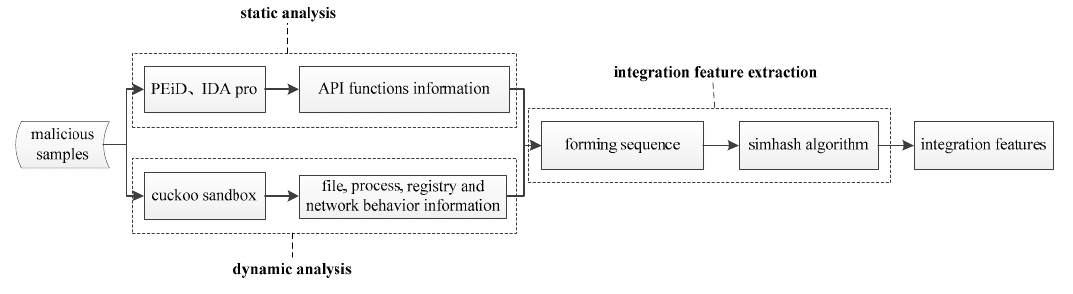
Figure 1. The process of the simhash-based integrative feature extraction algorithm. (PEiD (PE iDentifier), IDA Pro (Interactive Disassembler Professional)).